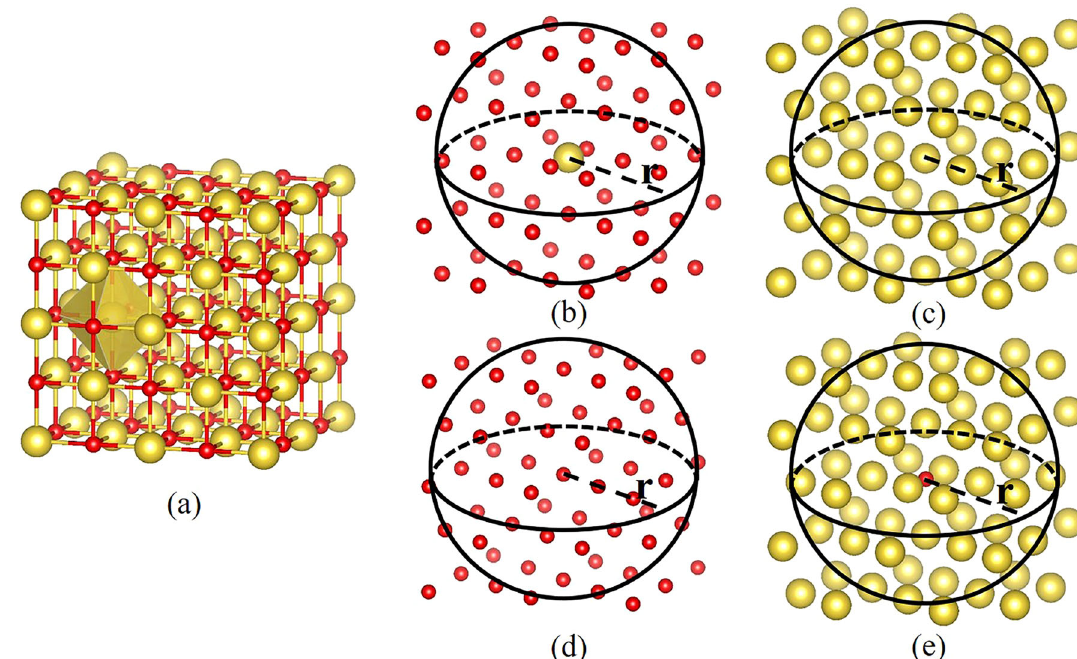
Fig. 5 Illustration of atom-speci fi c persistent homology point clouds. a the original crystal structure of NaCl with red atom being Cl and yellow atom being Na. Four atom-speci fi c point clouds are established by Na-Cl ( b ), Na-Na ( c ), Cl-Cl ( d ), and Cl-Na ( e ),